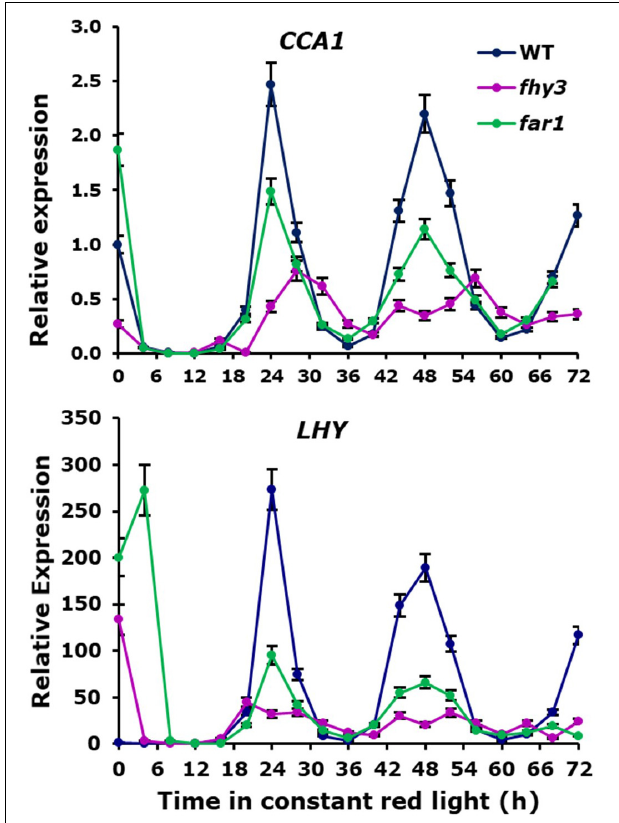
FIGURE 8 | Confirmation of expression patterns of selected central clock genes in constant red light. Wild type, fhy3 and far1 mutant seedlings were germinated and entrained in 12 h white light: 12 h dark cycles for 1 week before transfer to constant red light. Expression of CCA1 and LHY was calculated relative to Actin. Data represent the means of three biological replicates ±